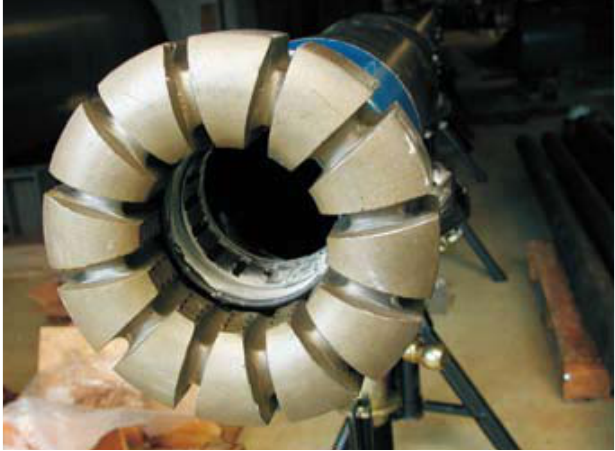
Figure 2. The core bit and core catcher assembly.